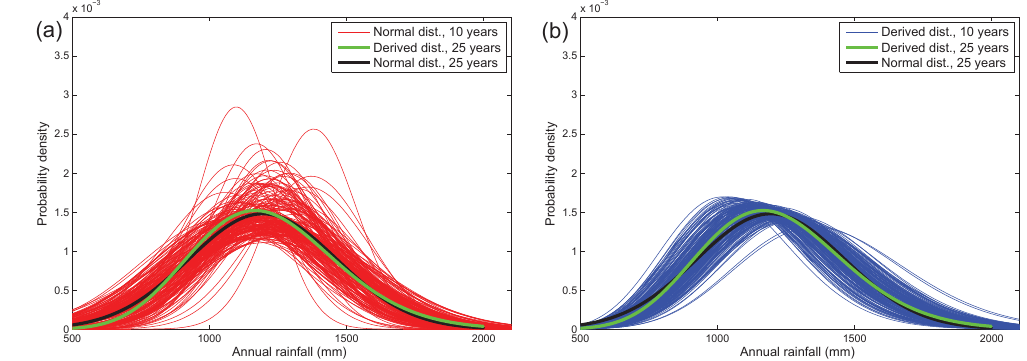
Figure 5. Estimated pdfs for 10-year subsamples using normal distributions (red, a ) and derived distributions (blue, b ) in Concepción.